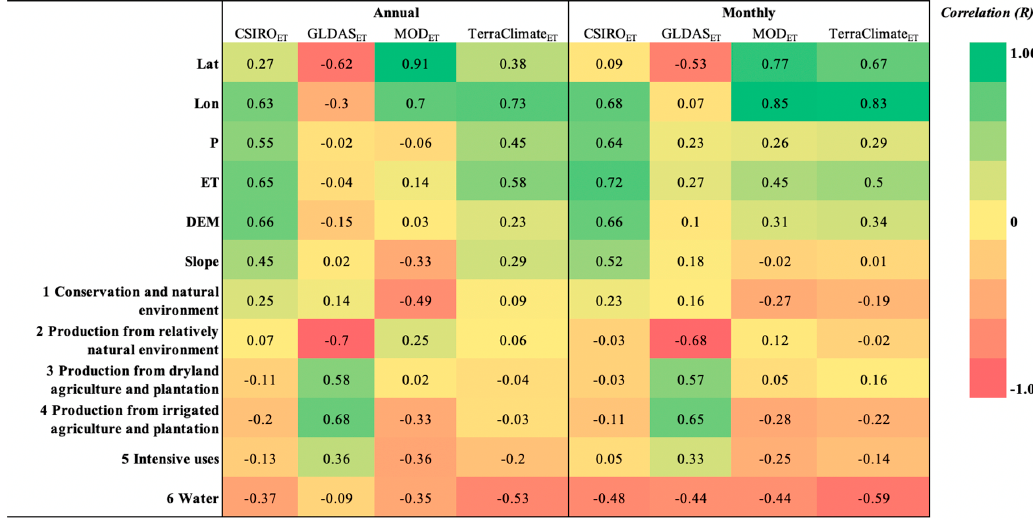
Figure 9. Heatmap of pairwise correlation (Pearson) values between RMSE of evapotranspiration (columns) and the catchment characteristics (rows) for the 22 catchments in the Murray Darling Basin. Numbers in the grids show the correlation coefficients.